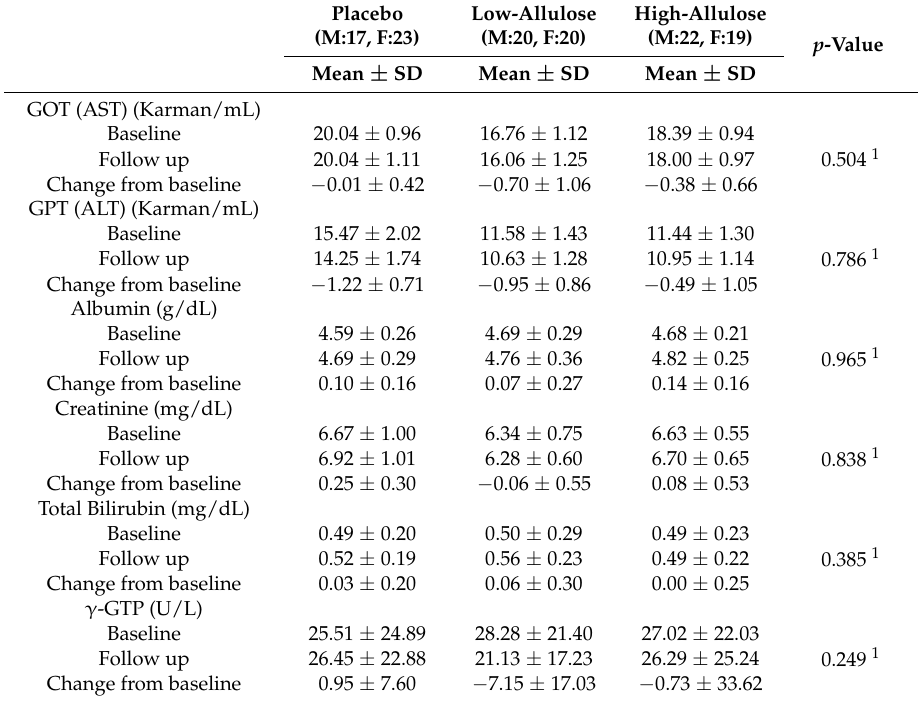
Table 9. Dose-dependent effect of D -allulose supplementation for 12 weeks on plasma GOT, GPT, albumin, and creatinine levels in overweight or obese